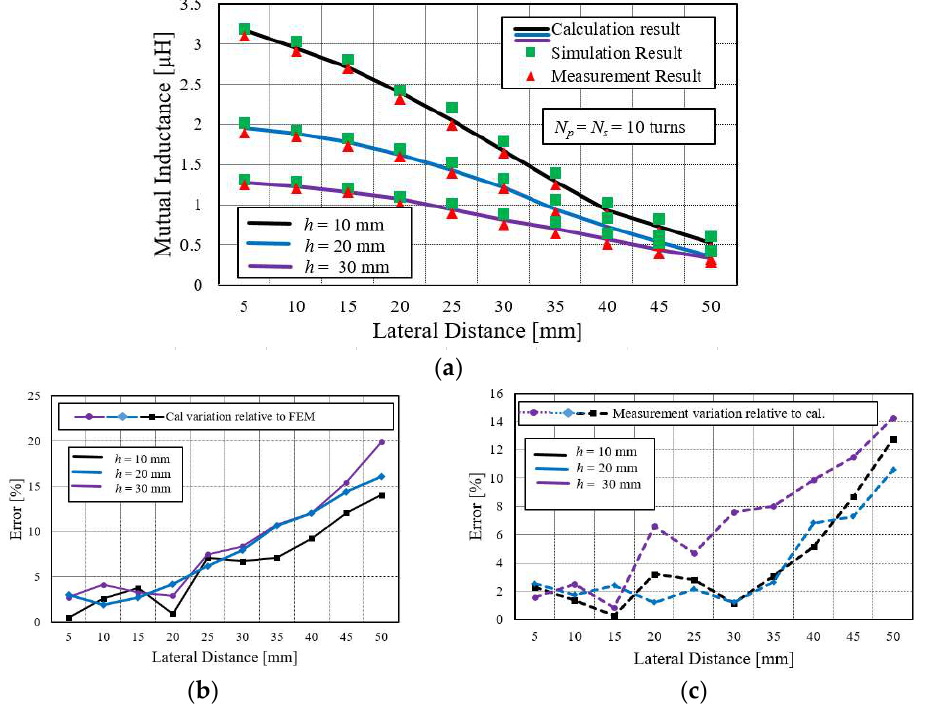
Figure 7. ( a ) Mutual inductance comparison between small primary and small secondary coils at various lateral misalignment distances. ( b ) Calculation variation relative to simulation (FEM) for N = 10. ( c ) Measurement variation relative to calculation.